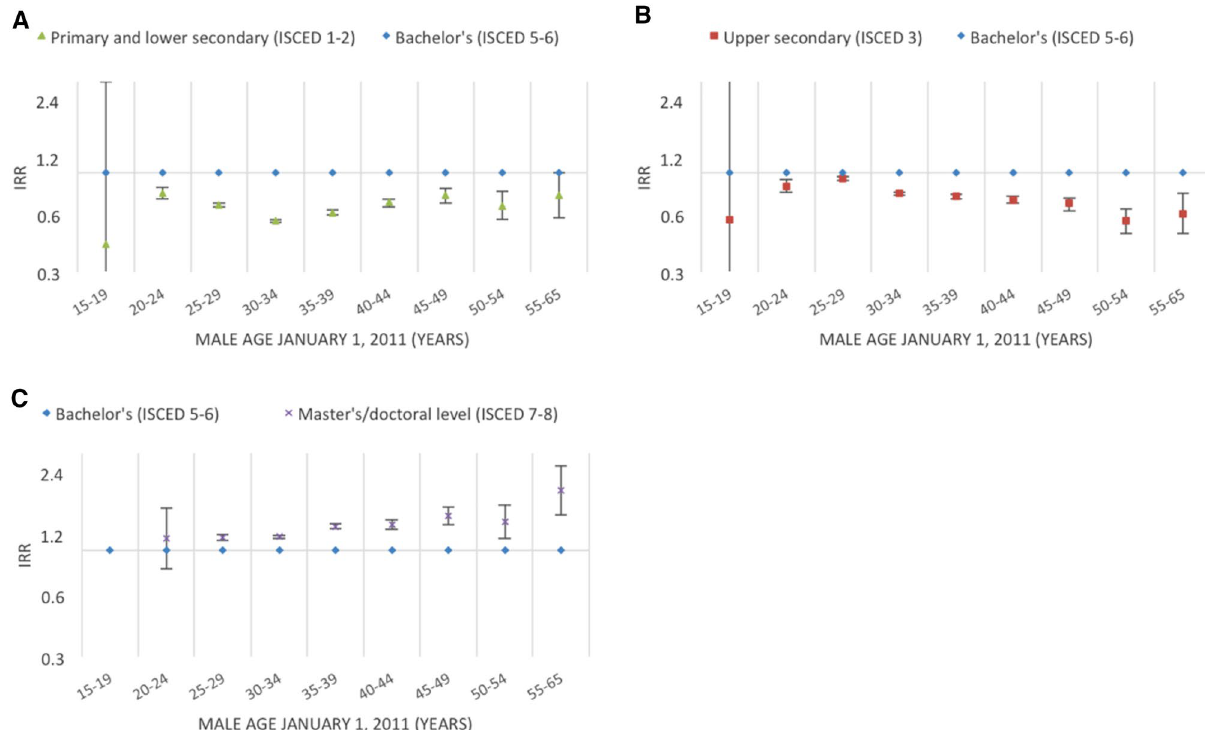
Figure 4. Incidence rate ratios (IRR) of fathering a child according to educational level 1 and age 2 . Men aged 15–65 years living in Denmark January 1, 2011 to December 31, 2015. 1 Highest educational level attained (as of January 1, 2011) was categorised according to the Danish International Standard Classification of Education 15, D-ISCED-15, and divided into primary and lower secondary (ISCED 1–2), upper secondary (ISCED 3), bachelor’s degree or equivalent (ISCED 5–6), and master’s/doctoral level (ISCED 7–8). No men in the group 15–19 years had a master’s/doctoral level education, thus the IRRs in this age group is not estimated. 2 Age groups according to the man’s age by January 1,